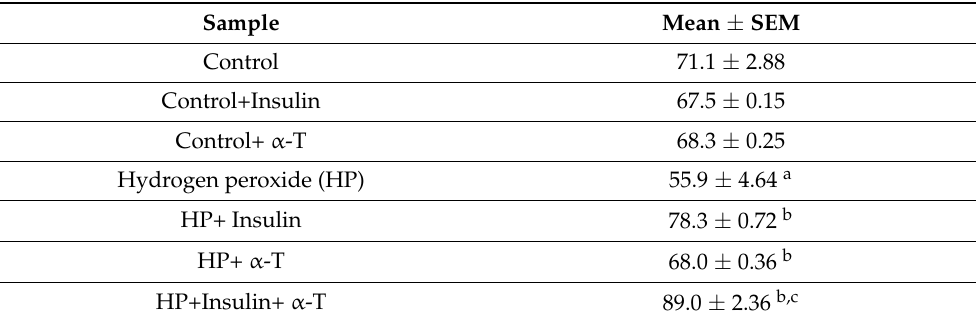
Table 1. The effect of pre-incubation with insulin and α -tocopherol ( α -T) on mitochondrial membrane potential in brain cortical neurons exposed to hydrogen